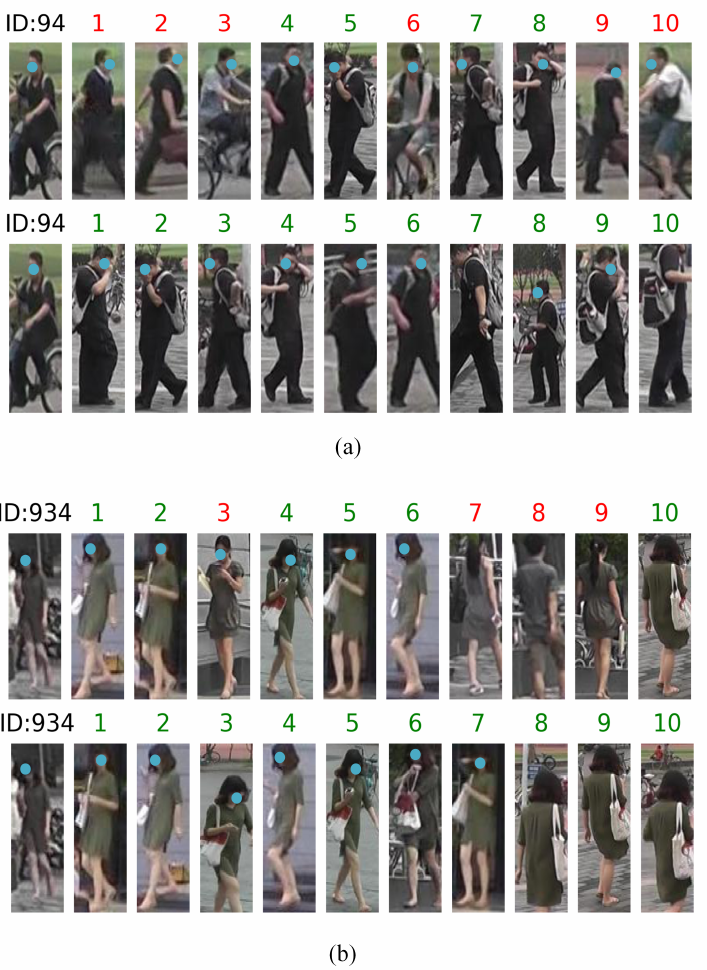
Figure 11. Visualization results of networks (without local branch, non-local, IBN, and attribute); the second line is the result of the method proposed in this paper. We select two images with different IDs from the query. ( a ) Rank result visualization of ID 94; ( b ) Rank result visualization of ID 934. From Figure 12, we selected pedestrian images with IDs 47 and 288 from the query. The baseline (without local branch, non-local, IBN, and attribute) that did not use attributes had more incorrect matches. For the pedestrian with ID 47, the baseline (without local branch, non-local, IBN, and attribute) had some errors on the “backpack” and “bag” attributes. For the pedestrian with ID 288, the baseline did not correctly match the “hair”